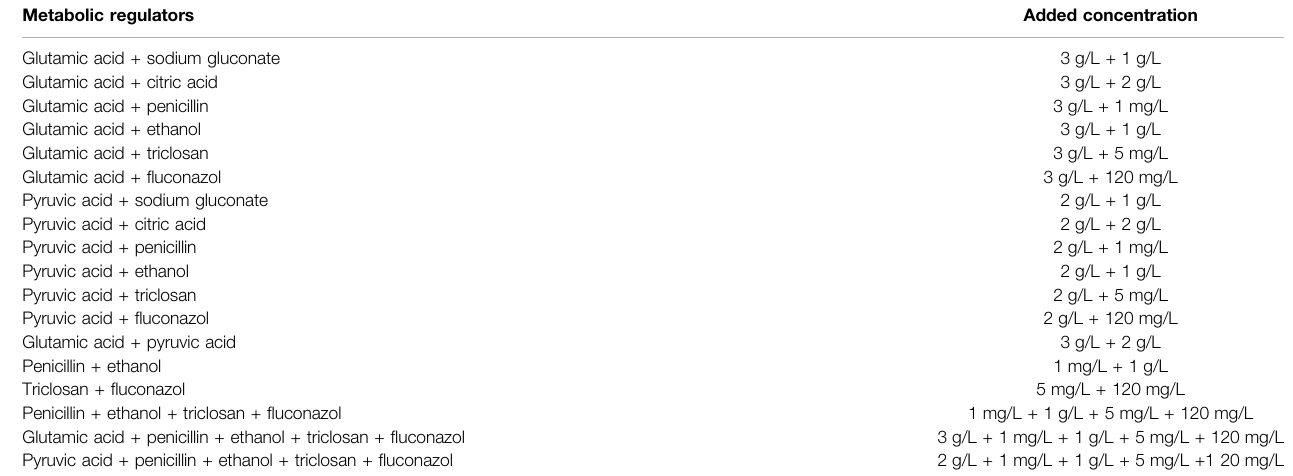
TABLE 2 | Combined addition of metabolic regulators. Metabolic